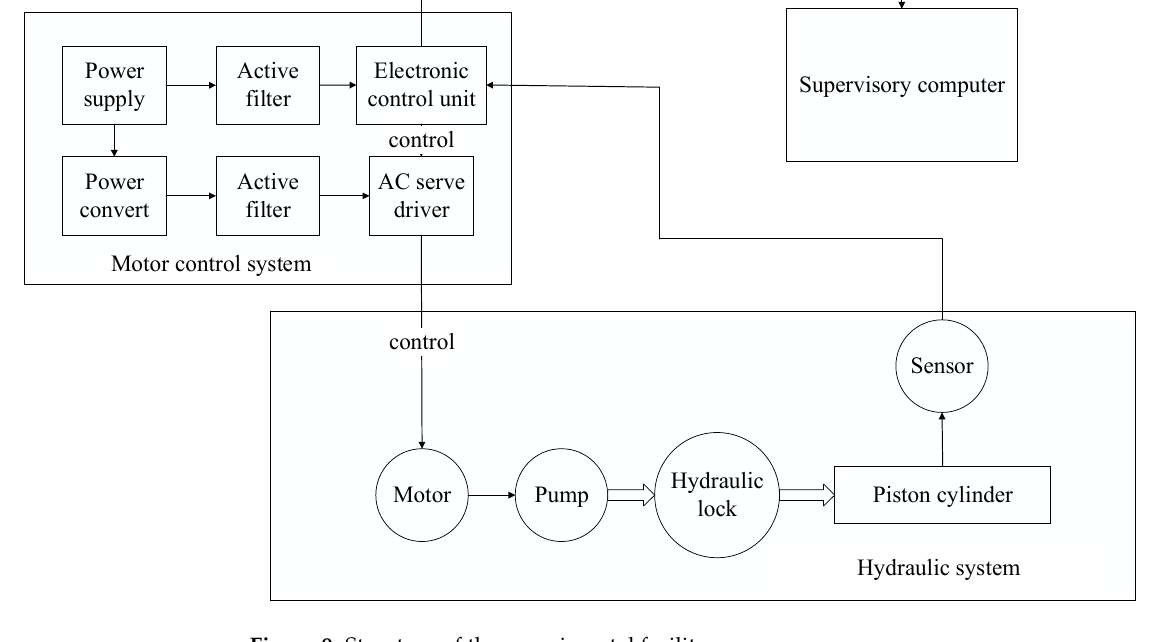
Figure 9. Structure of the experimental facility.